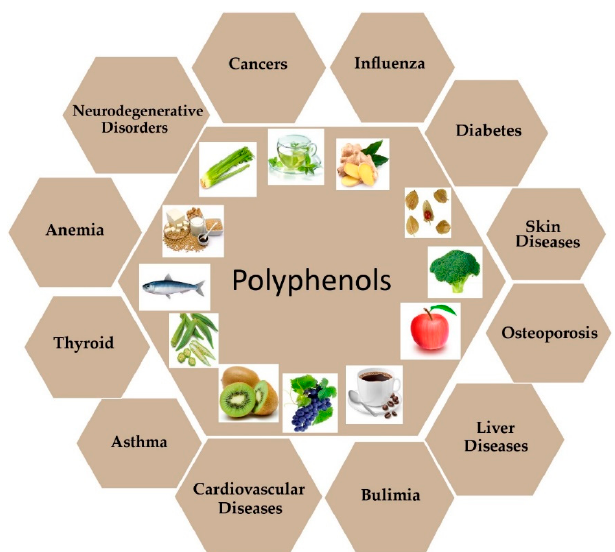
Figure 1. Health benefits effect of dietary polyphenols. Polyphenols are largely found in fruits, vegetables, spices, and beverages. Most of these compounds are involved in protection against the development of chronic diseases such as cardiovascular diseases (CVDs), neurodegenerative diseases, cancer, diabetes, osteoporosis, and liver diseases.